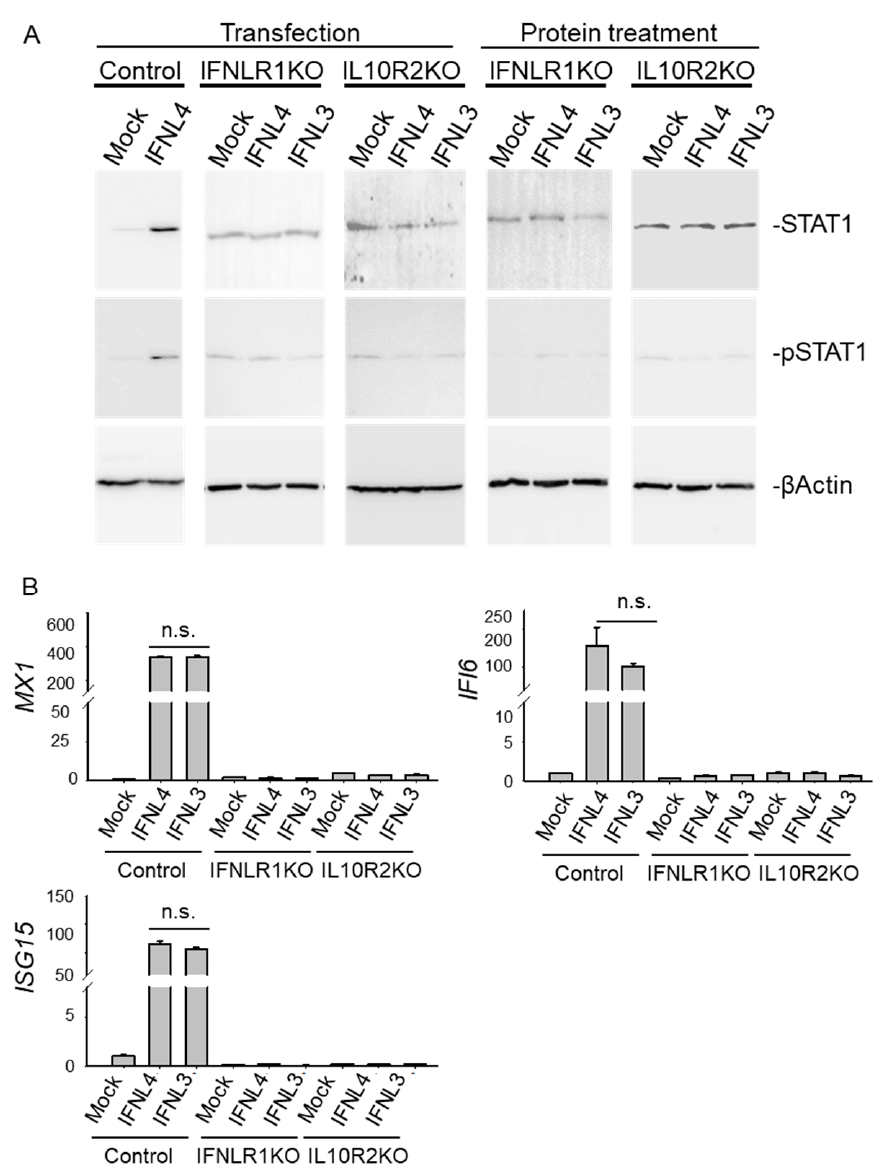
Figure 6. The IFNLR1/IL10R2 receptor complex is indispensable for the activation of JAK-STAT signaling triggered by IFNLs. ( A ) Wild type, IFNLR1 and IL10R2 knockout HuH7 cells were transfected with non-tagged IFNL3 or IFNL4 for 48 h or stimulated with recombinant IFNL3 or IFNL4 protein for 24 h. Empty plasmid was used as a mock control. Levels of STAT1 and pSTAT1 were determined by immunoblot analysis. Each lane is representative of 4 biological replicates. ßActin was used as a loading control. ( B ) Relative expression of IFI6 , MX1 and ISG15 was determined by real time PCR in transfected cells. GAPDH was used as internal control. The data are presented as mean ± SEM ( n ≥ 4).